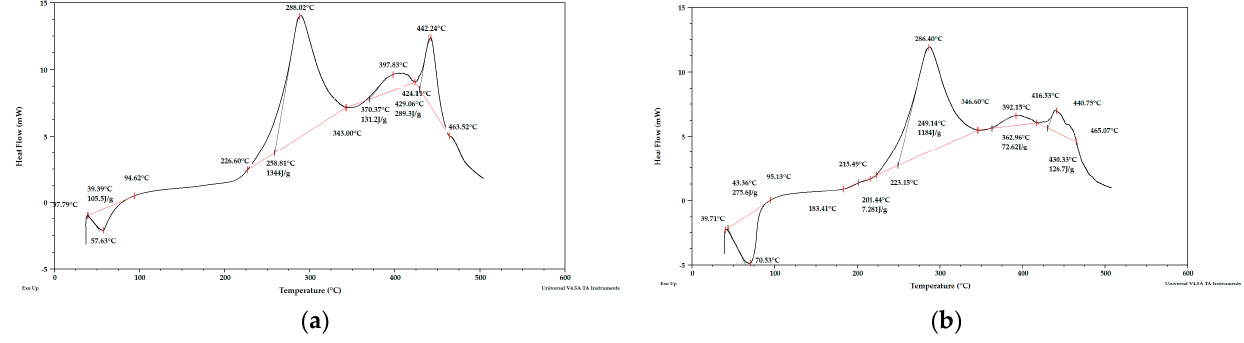
Figure 12. PDSC curves for fresh apple pomace ( a ) sample 1, ( b ) sample 2. Analysis in an oxygen atmosphere.